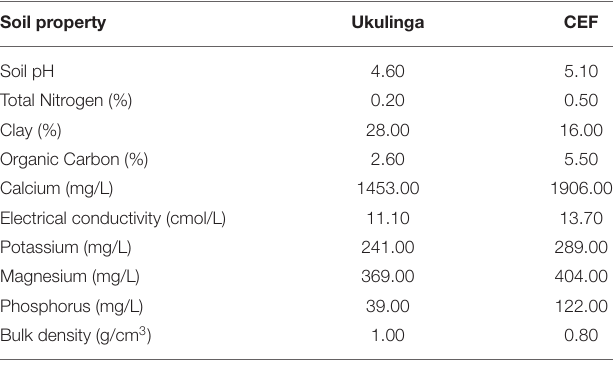
TABLE 2 | Physicochemical properties of soils used at the CEF and